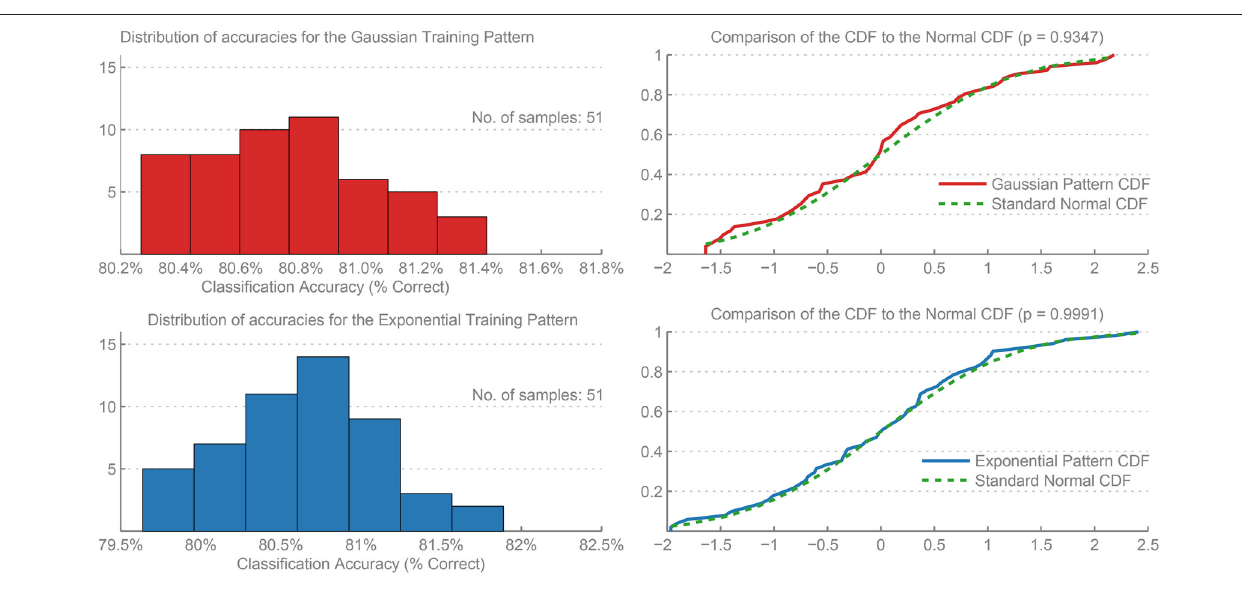
FIGURE 5 | Histograms of the distribution of errors and their Cumulative Distribution Functions (CDF) for the Gaussian and Exponential training patterns. The results were calculated over 51 independent trials of each network. A comparison to the CDF of a Standard Normal distribution is included, and the p -value for a one-sample Kolmogorov-Smirnov test provided, demonstrating that both distributions are normally